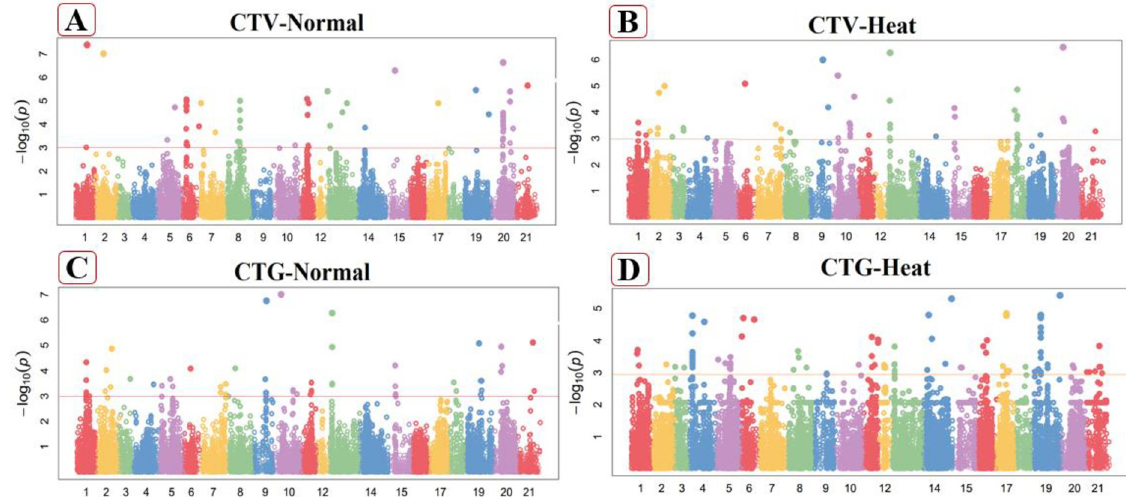
Fig 2. Manhattan plot of Canopy Temperature at vegetative stage (CTV) in normal ( A ), heat stressed ( B ) conditions and Canopy Temperature at grain filling stage (CTG) in normal ( C ) heat stressed ( D ) conditions. These figures exhibiting the position of significant SNPs and -log10(p) linked with specific traits in normal and heat stressed